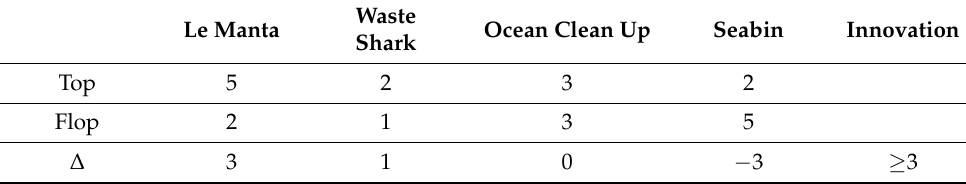
Table 4. Top–Flop Analysis